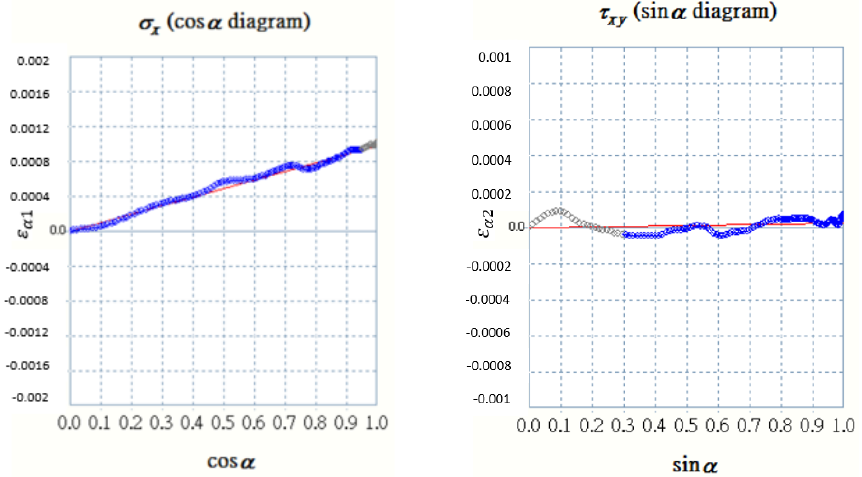
Figure 13. Variations of ε α 1 and ε α 2 with respect to cos α and sin α for a laser power of 600 W. Figure 13. Variations of 𝜀 Figure 13. Variations of 𝜀 (cid:3080)(cid:2869) and 𝜀 (cid:3080)(cid:2870) with respect to cos 𝛼 and sin 𝛼 for a laser power of 600 W. (cid:3080)(cid:2869) and 𝜀 (cid:3080)(cid:2870) with respect to cos 𝛼 and sin 𝛼 for a laser power of 600 W. Figure 13. Variations of 𝜀 (cid:3080)(cid:2869) and 𝜀 (cid:3080)(cid:2870) with respect to cos 𝛼 and sin 𝛼 for a laser power of 600 W.